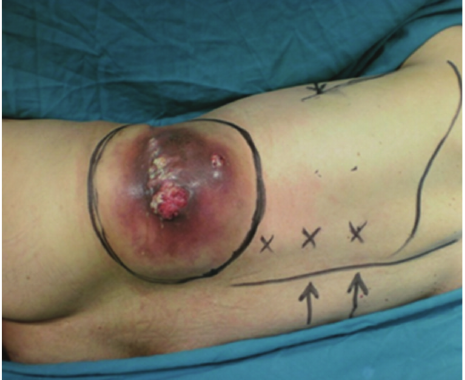
Figure 3: The specimen with the distal 11th rib (arrow).